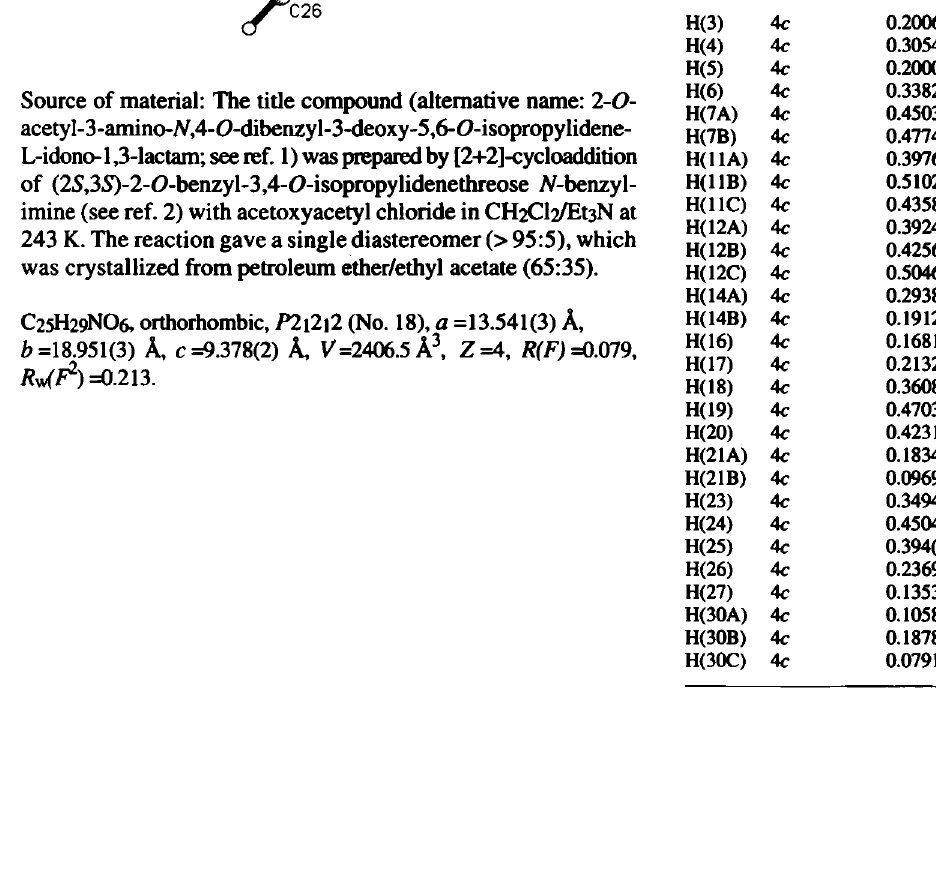
Table 2. Final atomic coordinates and displacement parameters (in Â 2